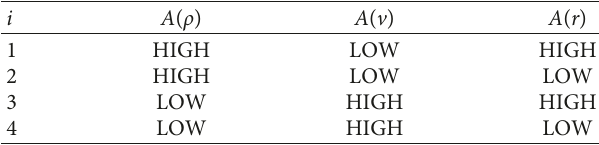
Figure 2: Membership functions of (a) mainstream density, (b) mainstream speed, and (c) visibility. Table 2: Combinations of input variables used in fuzzy